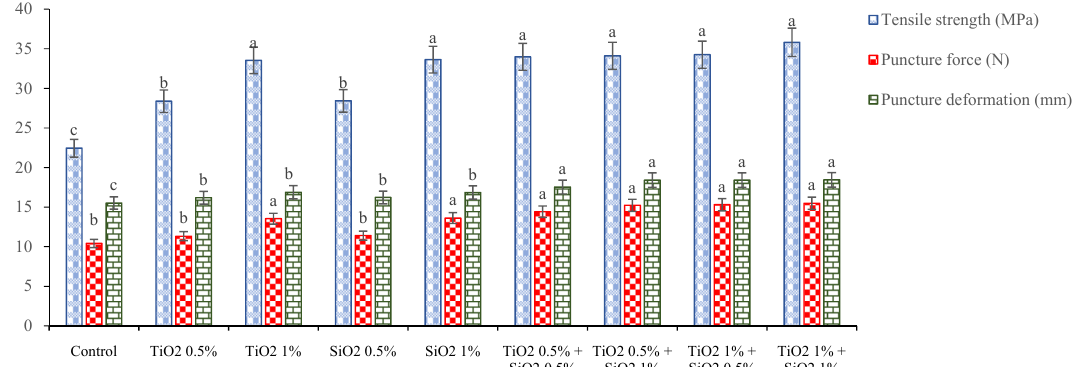
Fig. 1. Mechanical properties of quince seed mucilage supplemented with titanium dioxide (TiO 2 ) and silicon oxide (SiO 2 ) nanoparticles. a-c Different lower case letter among groups indicates significant differences (P < 0.05).